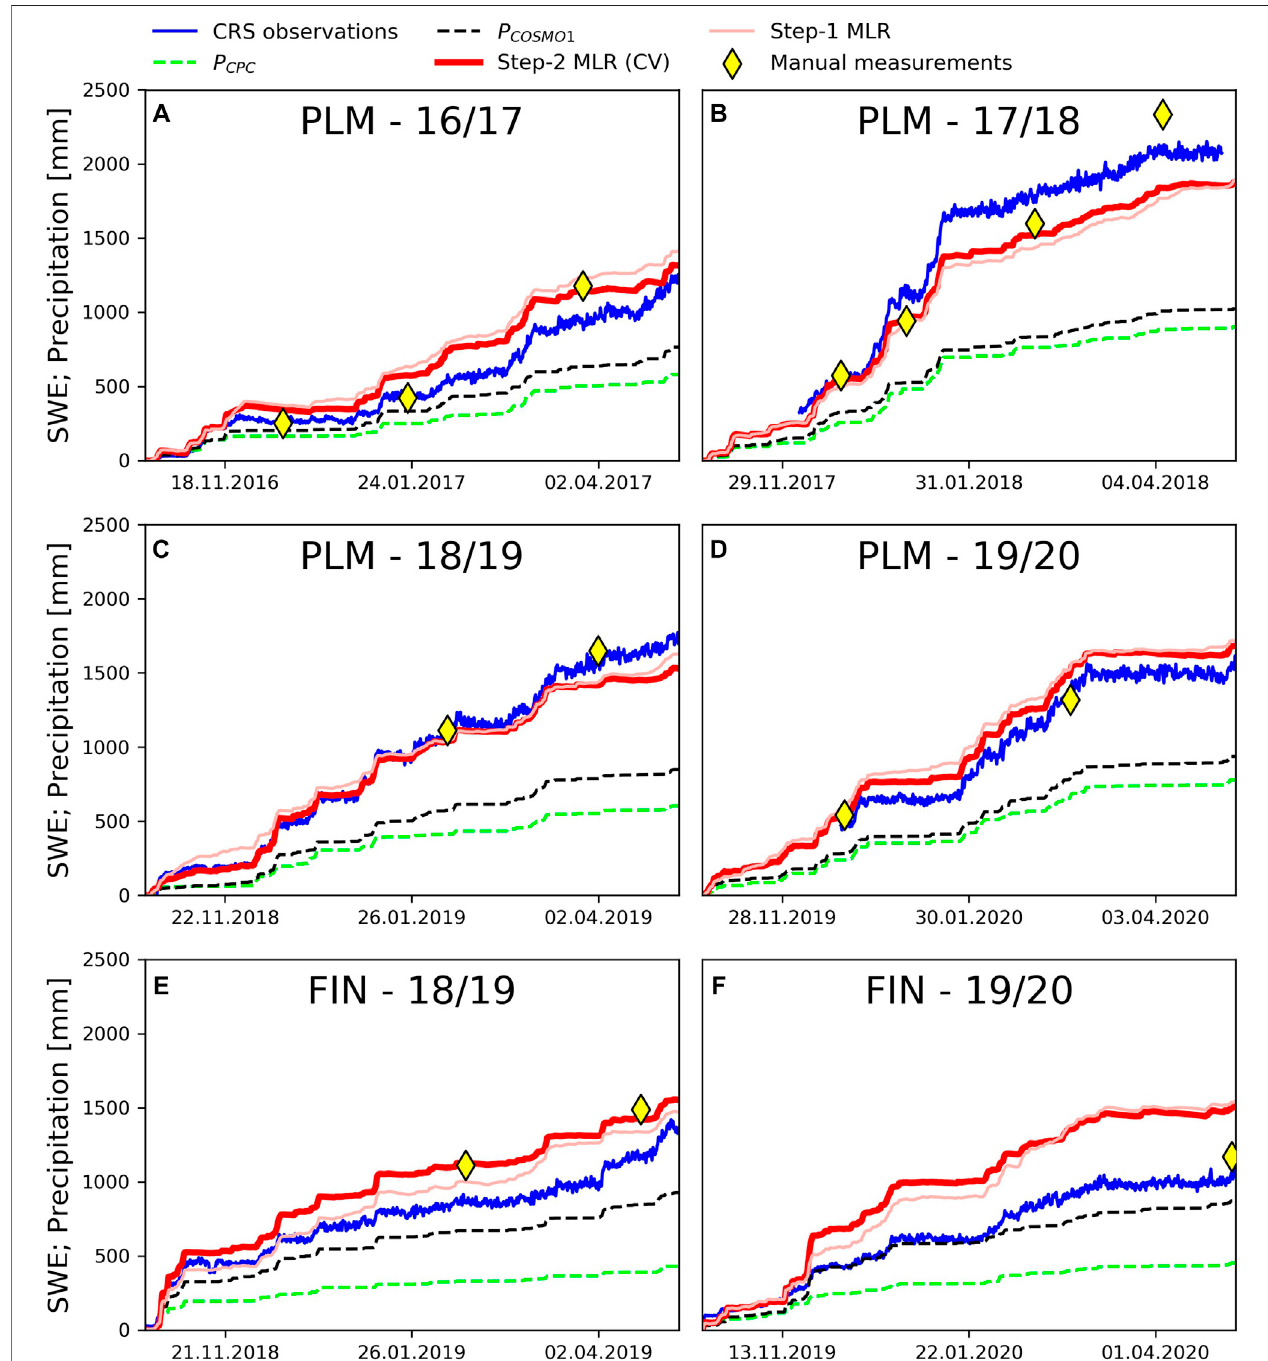
FIGURE9| TimeseriesoftheStep-1andStep-2estimates,asobtainedfromtheMLRmodelswithSWEobservationsfromtheCRS,manualSWEmeasurements, CombiPrecip and COSMO-1 precipitation estimates (A) : Plaine Morte 16/17 (B) : Plaine Morte 17/18 (C) : Plaine Morte 18/19 (D) : Plaine Morte 19/20 (E) : Findel 18/19 (F) : Findel